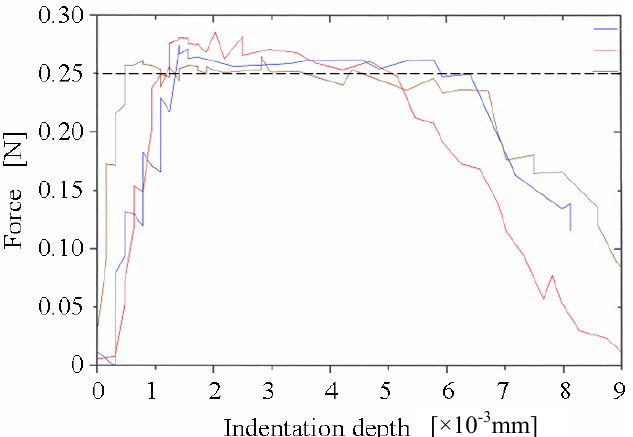
Figure 7. Dynamic indentation curves of imitation skin by SMA coil spring transducer action of applied DC 2.0 V and 0.5 A.